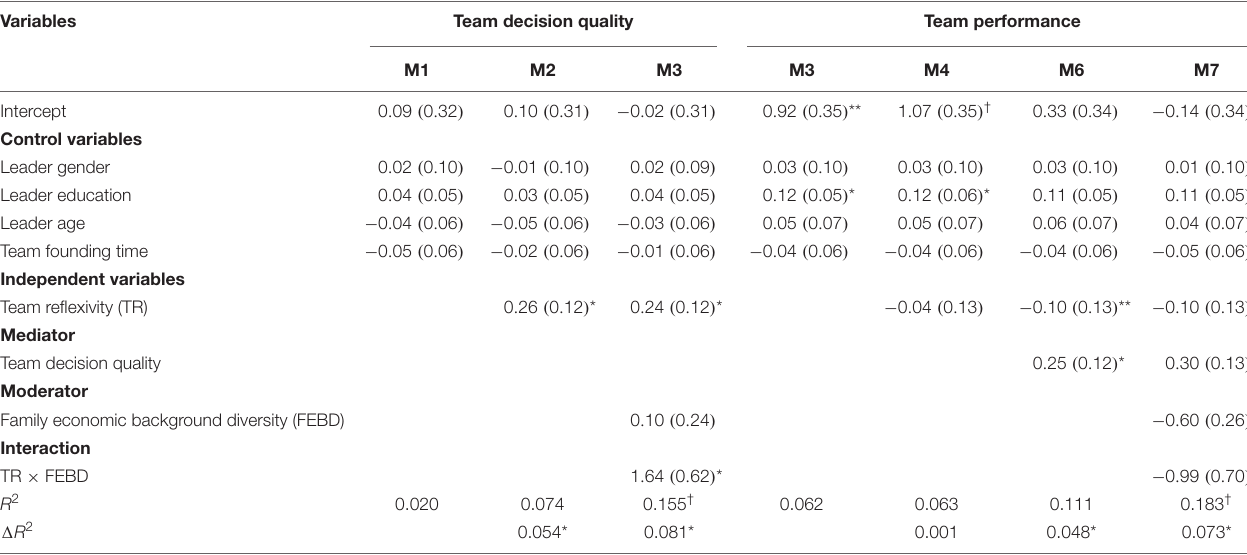
TABLE 3 | Regression results for mediation and